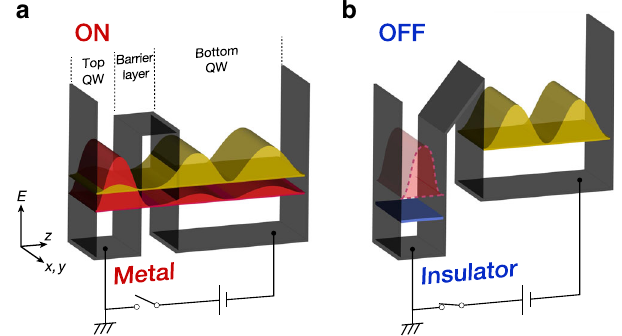
Fig. 4 Schematic illustration of the Mott transistor based on the metal – insulator transition induced by resonant tunneling effects. a On states (same as the metallic states shown in Fig. 1b) and b off states. Owing to the energy separation of QW states between the top and bottom QWs, there is no RT effect between the two QWs, and hence the top QW becomes a marginal Mott insulator in off states. The Mott transition (on/ off operation) is controlled by applying a voltage between the on the quantum RT effects between designed wave functions of strongly correlated electrons.